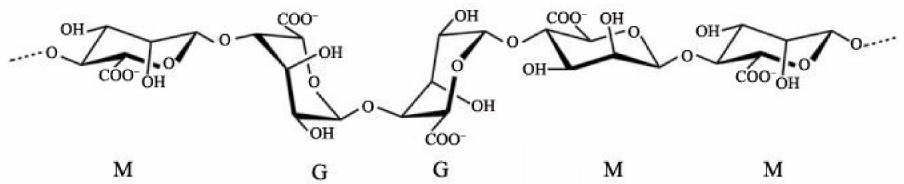
Figure 1. The structural schematic diagram of chain conformation and M/G block distribution of alginate molecular chain.